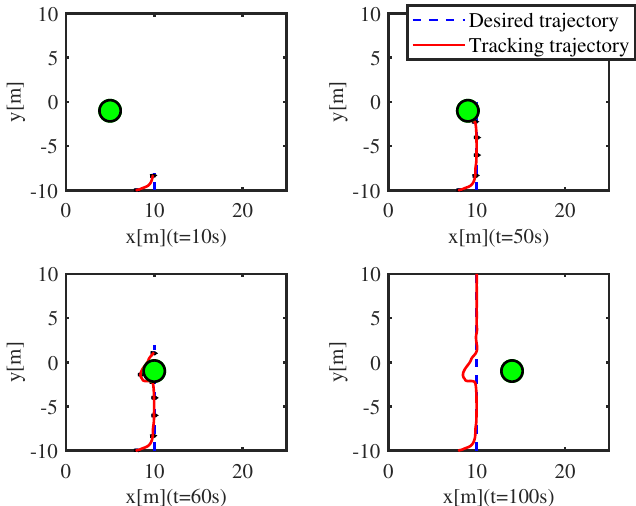
Figure 11. Four moments of trajectory tracking control under